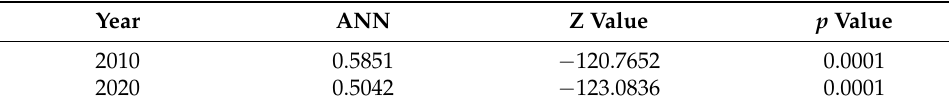
Table 4. ANN index in Jiangning District (2010, 2020).